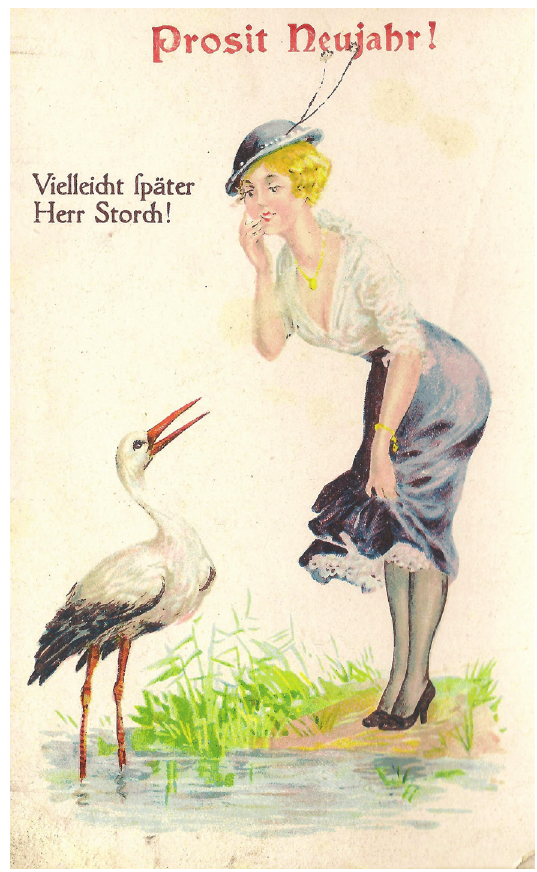
Figure 3. Vielleicht später, Herr Storch! (Perhaps later, Mr Stork!) Picture postcard intended for sending New Year greeting, undated, ca.